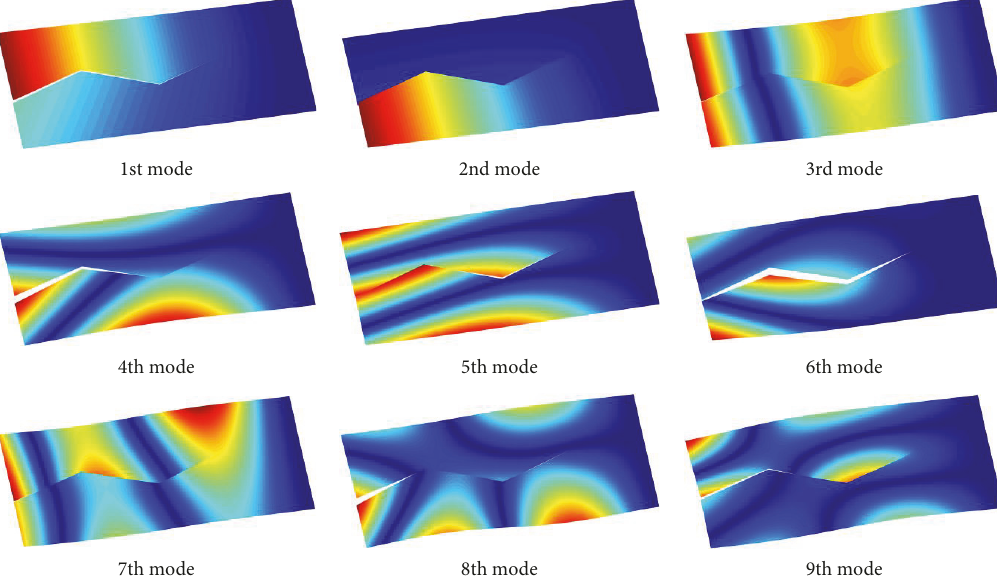
Figure 13: The first nine mode shapes of the FCFF plate with irregular I-shaped